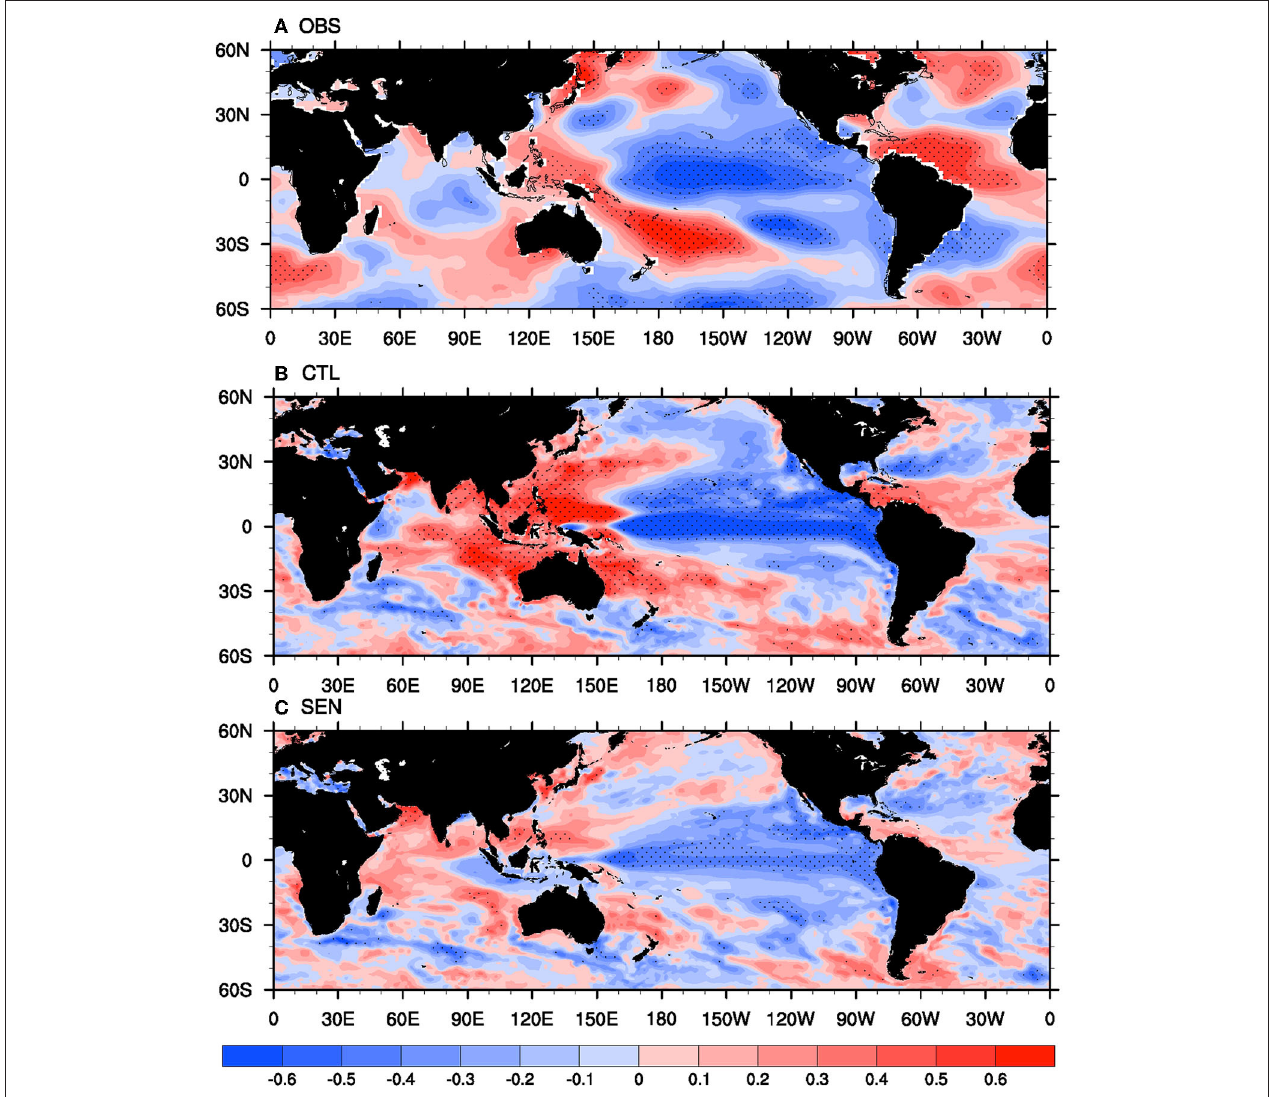
FIGURE 10 | Correlation coefficient between ISMR and seasonal mean SST for the period 1981–2017 in (A) observation, (B) CTL, and (C) SEN run. The black dots show regions where correlation is significant at 90% confidence